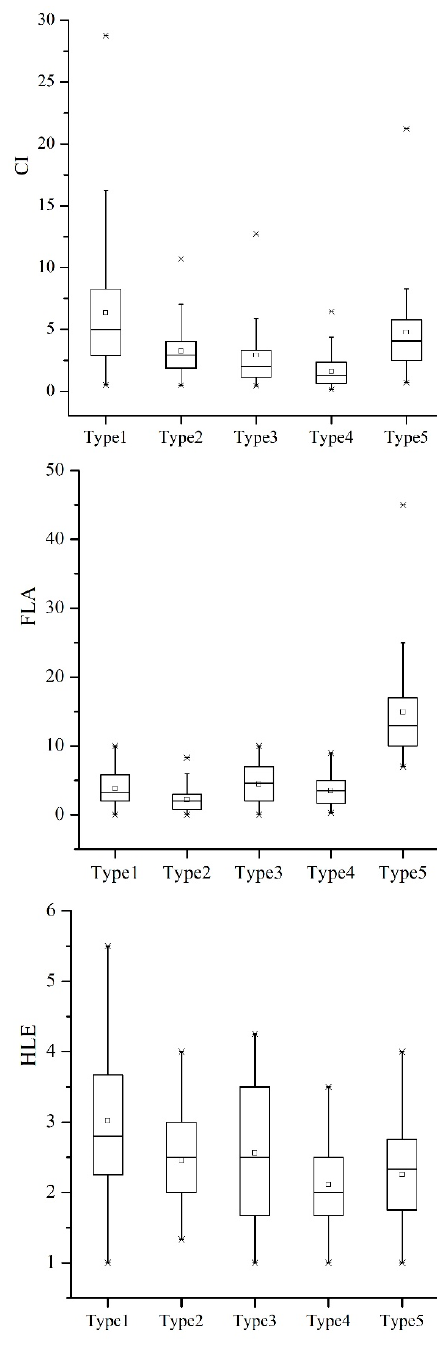
Figure 4. Description of household profiles. Boxplots represent the mean (black point), median (solid lines), first and third quartiles (contained in the boxes), dispersion (dashed line), and outliers (asterisk) of the distribution of the ranks of each trait. Notes: Type 1, non-farm households; Type 2, part-time households; Type 3, livestock breed households; Type 4, subsidized households; Type 5, traditional planting households.